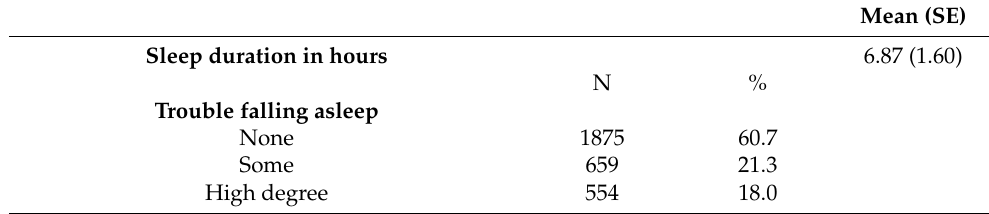
Table 2. Psychological distress (mental health) and sleep profile descriptives (N =